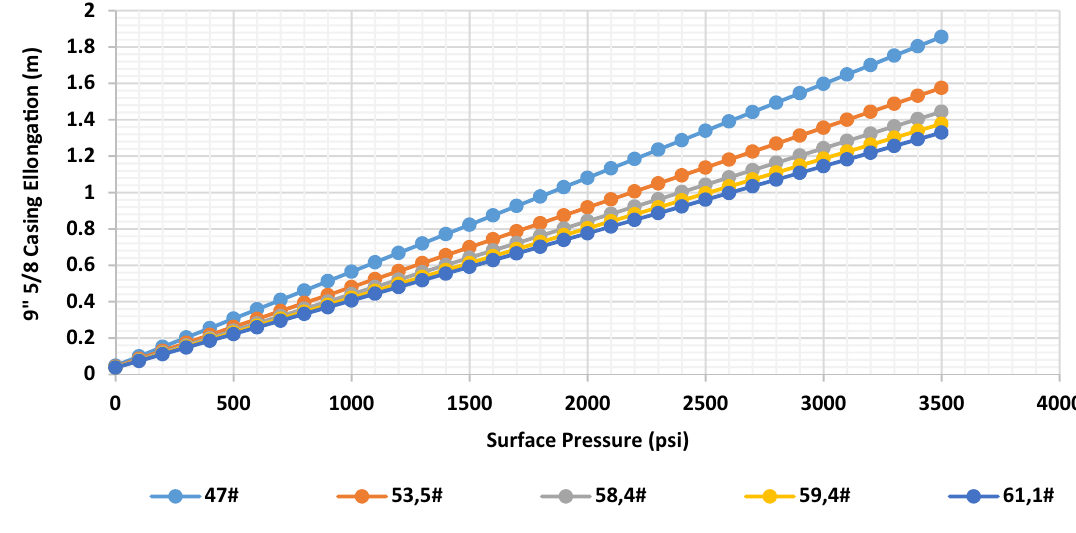
Fig. 5 Different casing grade elongation due to additional tensile